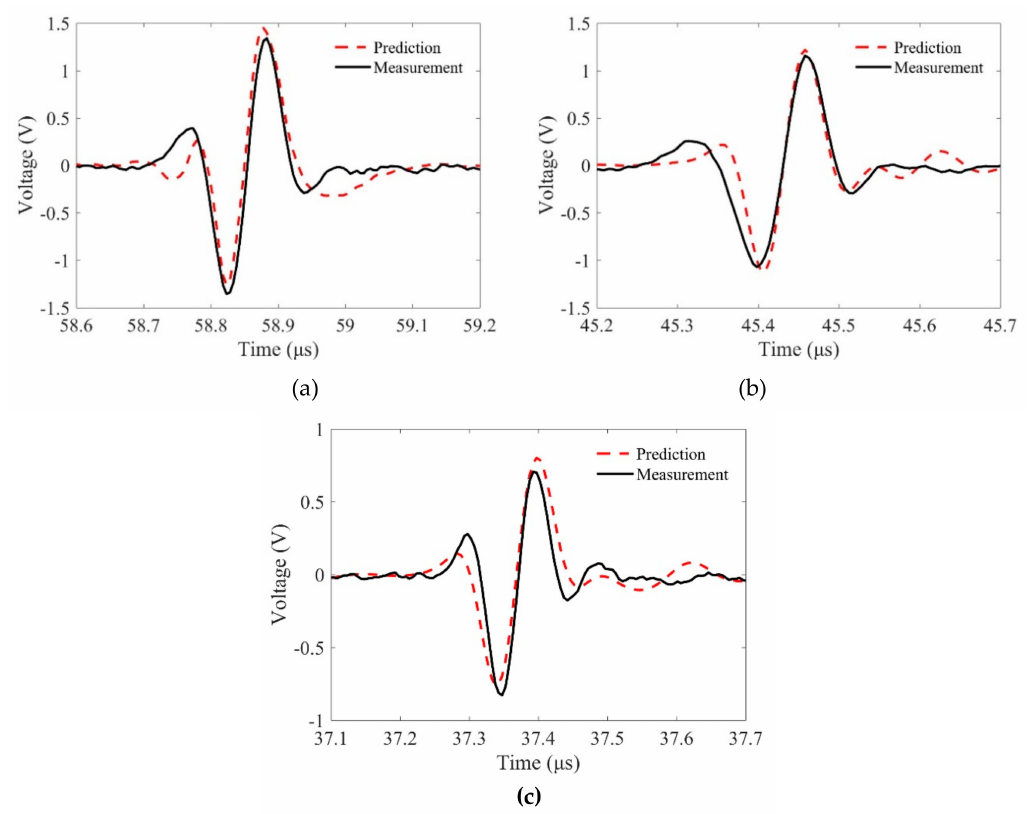
Figure 13. Comparisons of the flaw signals between predictions and measurements at an incidence angle of θ p 1 = 20 ◦ when the radii of curvature are ( a ) R = ∞ , ( b ) R = 50 mm, and ( c ) R = 30